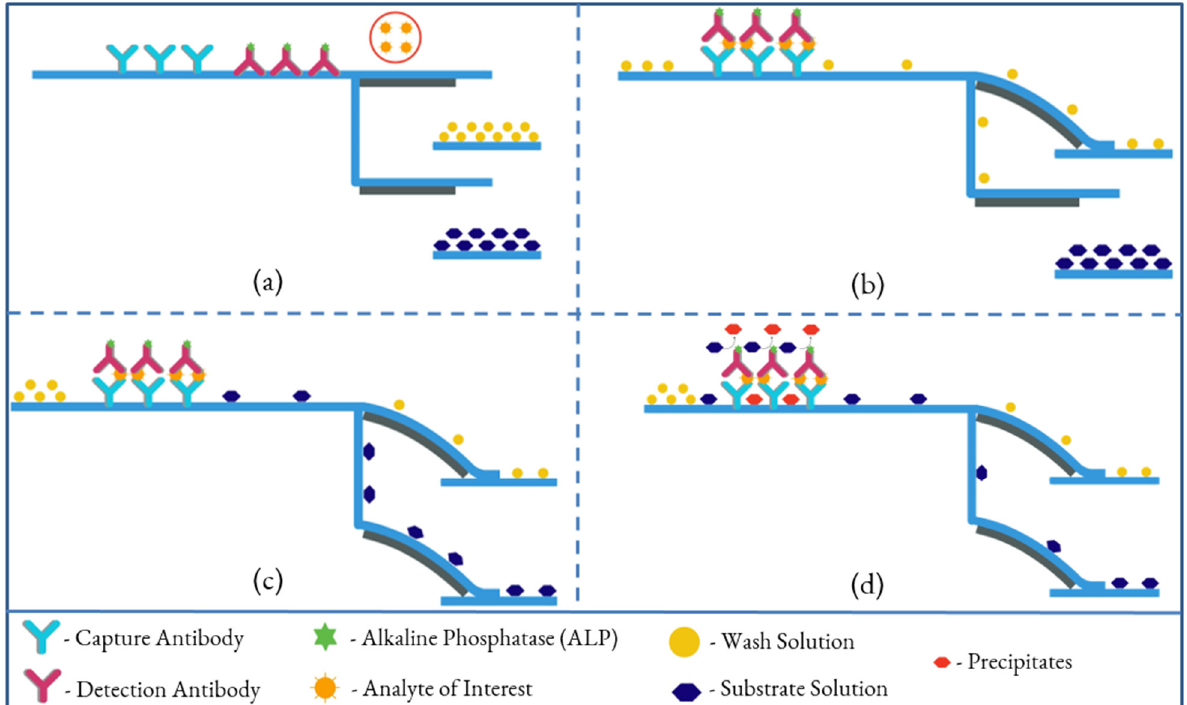
Figure 2. Illustration of performing an ELISA on a dual B-MaC assembly. ( a ): Activation of the first cantilever by introducing sample, ( b ): loading of wash solution onto the first cantilever, washing off any unabsorbed detection antibody from the conjugate pad, ( c ): activation of the second cantilever, initiating the loading of the substrate toward the detection zone, ( d ): colorimetric reaction and precipitation of reacted enzyme for quantifying the signal.